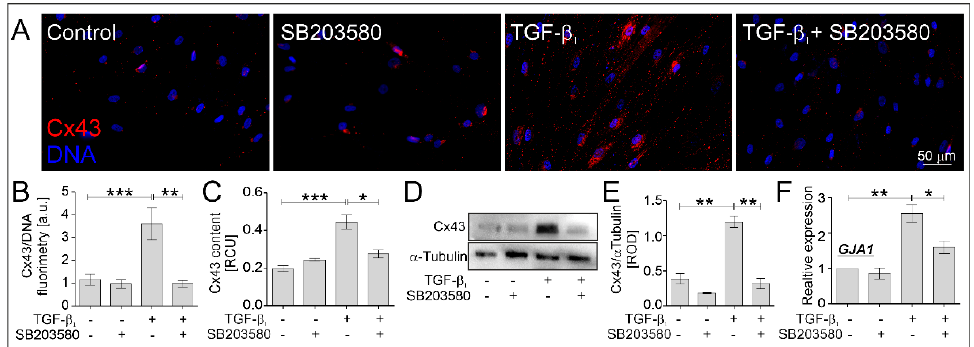
Figure 5. SB203580 significantly reduced the level of Cx43 in TGF- β 1 -treated HBFs AS. HBF AS populations were cultured without or with SB203580 (10 µM) in the absence or presence of TGF- β 1 (5 ng/mL) for five days. ( A ) Representative images of HBFs AS, immunostained for Cx43 (red) and counterstained for DNA (blue), were obtained. Scale bar = 50 µm. The levels of Cx43 in HBF AS cultures were determined ( B ) fluorometrically ( n = 11), ( C ) using in-cell ELISA ( n = 4) and ( D ) Western blot with ( E ) densitometric analysis ( n = 3). A representative membrane was shown. ( F ) The relative expression of GJA1 (encoding Cx43) in HBFs AS ( n = 4) cultured for one day in conditions described above was presented as a 2 −ΔΔ Ct mean value in relation to control genes ( 18S , B2M and GAPDH ) and control conditions. RCU—relative colorimetric units.